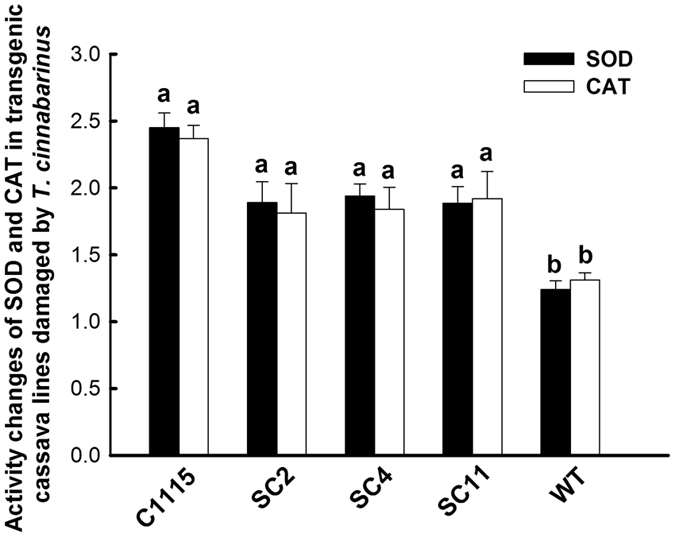
Changes in SOD and CAT activities in transgenic cassava lines damaged by T. cinnabarinus.The changes in SOD or CAT activities were presented as the ratio of the activities in 8 d–damaged leaf and the same leaf before being damaged by T. cinnabarinus. Different letters above the standard error bars indicate significant differences of activities of SOD or CAT among transgenic cassava lines, WT and C1115, which were based on the one-way ANOVA followed by Tukey’s HSD multiple comparison test (P < 0.05).